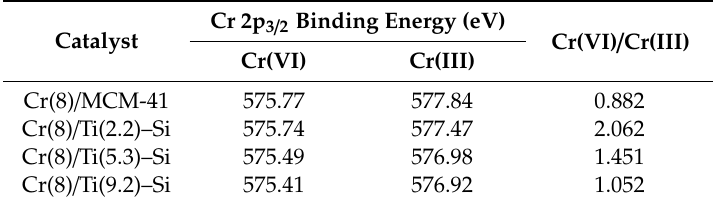
Table 2. XPS results of Cr(8) / MCM-41 and Cr(8) / Ti(x)–Si-nanocomposites where x = 2.2, 5.3 and 9.2 wt %